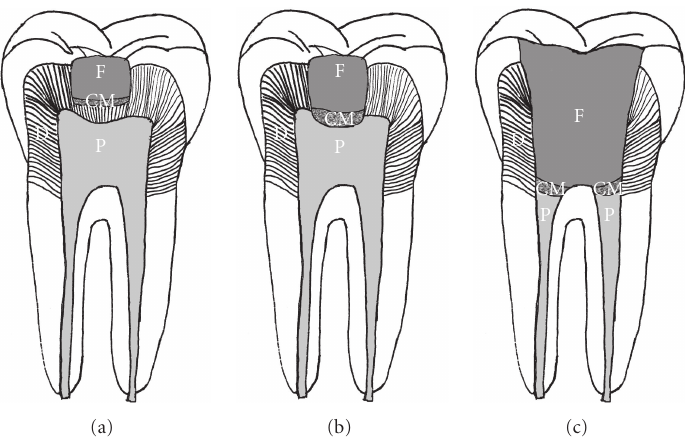
Figure 1: Vital pulp therapy. (a) Indirect pulp capping; (b) direct pulp capping; (c) pulpotomy. (D = Dentin; P = Pulp; CM = Capping material; F =